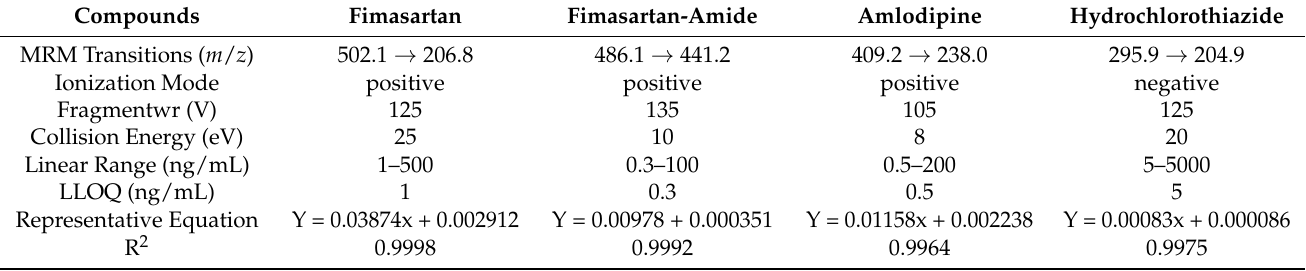
Table 1. MS/MS parameters for the detection and standard calibration curves for fimasartan, fimasartan-amide, amlodipine, and hydrochlorothiazide. Fimasartan Fimasartan-Amide Amlodipine